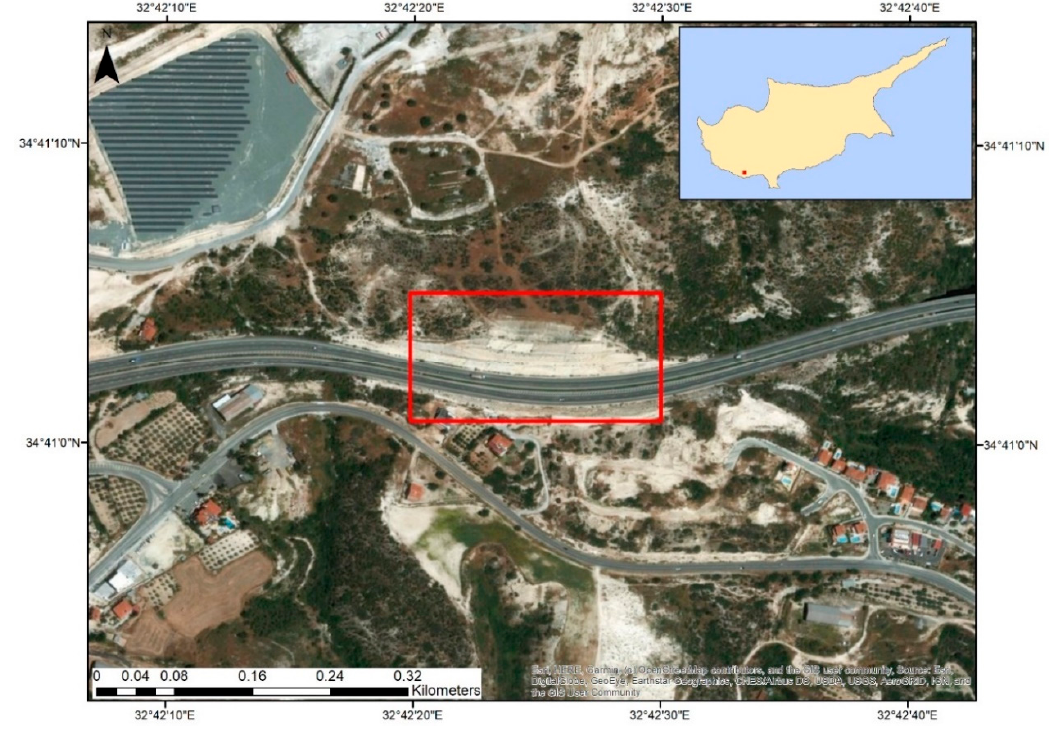
Figure 4. The case study area along the A6 motorway near Pissouri.